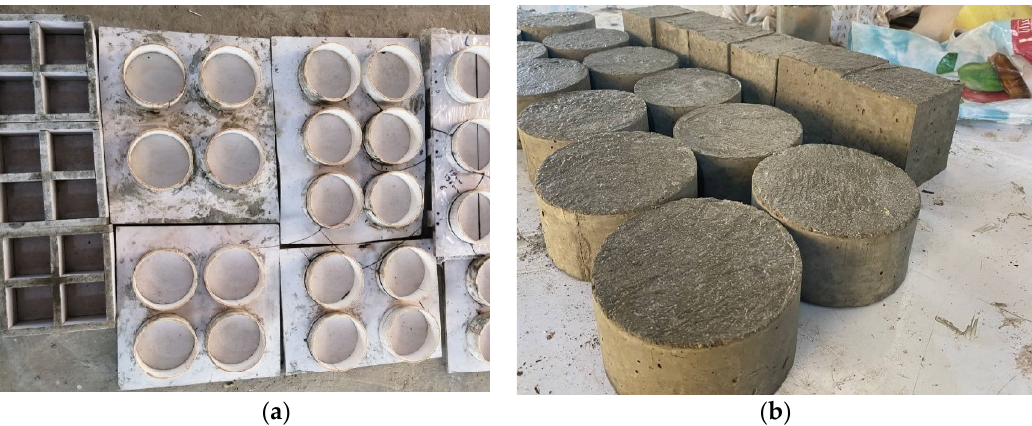
Figure 4. Impact and compressive strength specimens. ( a ) Specimen molds; ( b ) Cast specimens